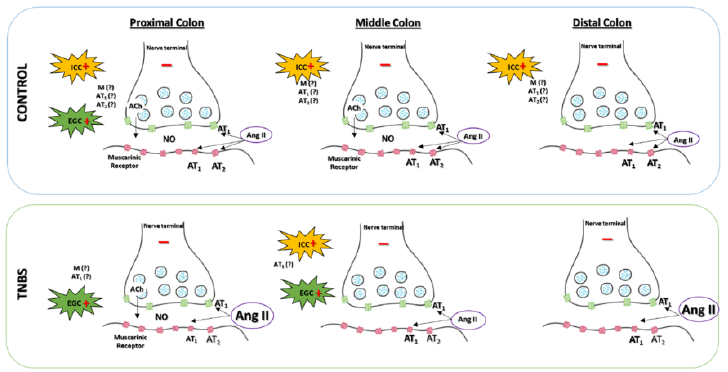
Figure 9. Schematic representation of the effect of Ang II in colonic reactivity along the colon of control ( top panel ) and TNBS-induced rats ( bottom panel ). Ang II activates AT 1 receptors, contracting all colonic regions of control and TNBS-induced rats. Ang II also activates AT 2 receptors along the colon of control animals, promoting colonic relaxation, but this effect is not observed in TNBS-induced rats. Animals with TNBS-induced colitis show higher tissue concentration of endogenous Ang II and decreased expression of AT 1 receptors but similar expression of AT 2 receptors. The intricate, Ang II-mediated colonic contraction involves a neuronal inhibitory component and a non-neuronal excitatory component. The neuronal component involves activation of muscarinic receptors and production of NO. The non-neuronal component includes activation of EGC and/or ICC, dependent on the colonic region. EGC—enteric glial cells; ICC—interstitial cells of Cajal; M—muscarinic receptor; NO—nitric oxide; (+)—excitatory mechanism; ( − )—inhibitory